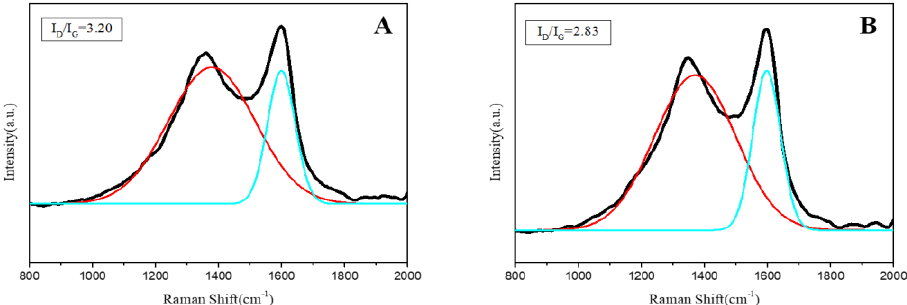
Figure 7. Raman spectra of the char residue ( A : EFMgO; B : ELDH1).